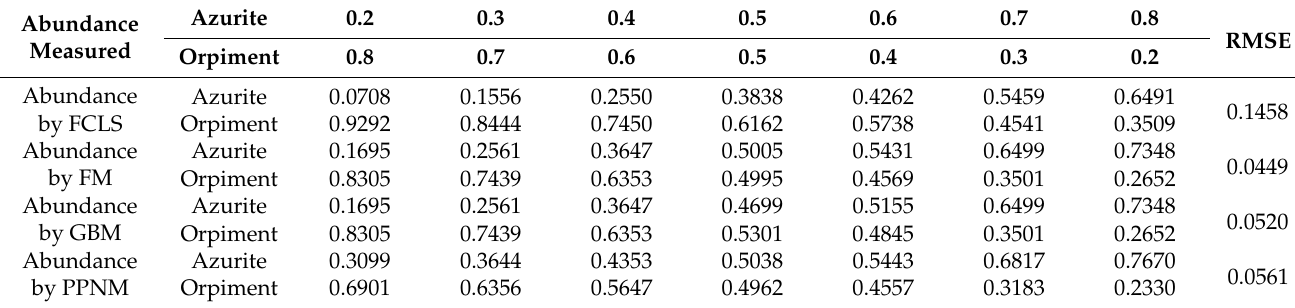
Table 4. Abundance estimated by different approaches for mixed pigment samples of azurite and orpiment.